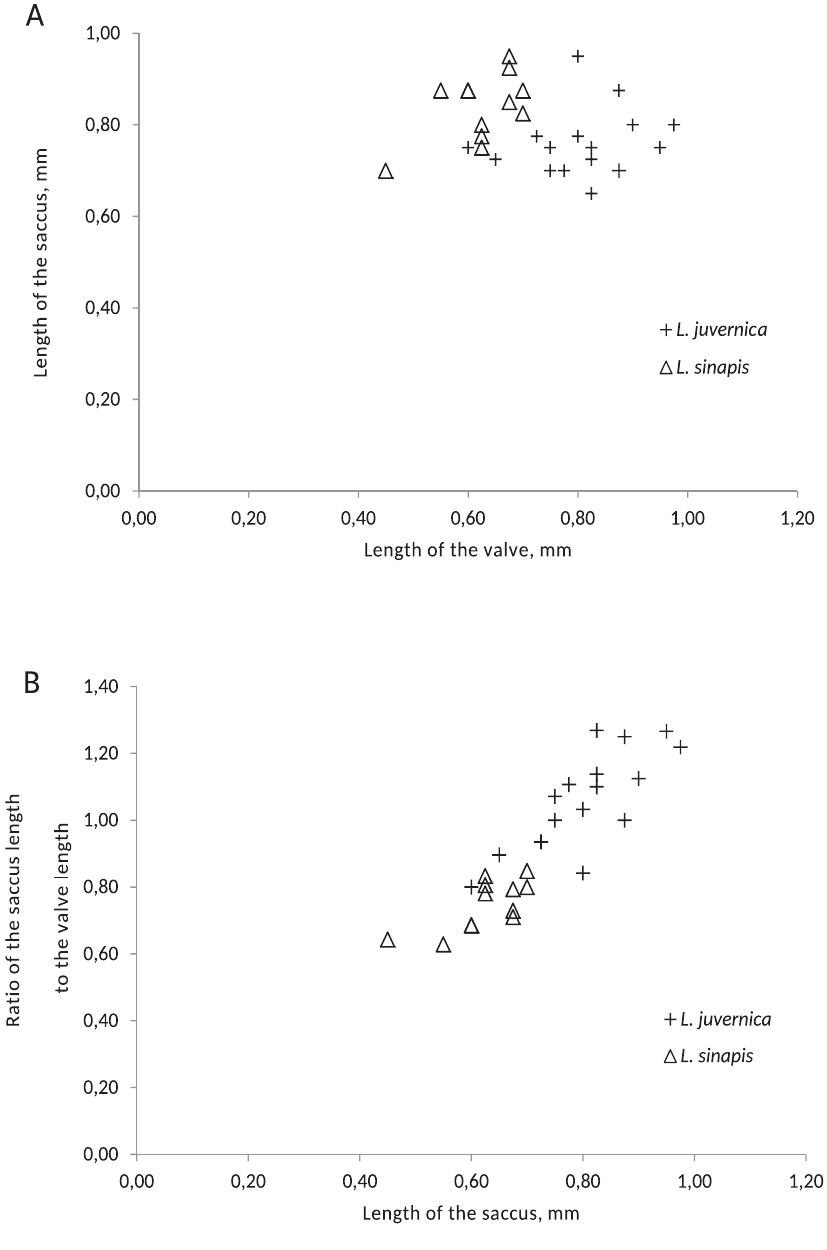
Figure 5. The saccus and valve lengths of the L. sinapis and L. juvernica . A Plot of the saccus length against the valve length of L. sinapis and L. juvernica , as identified by molecular markers B Plot of the ratio of the saccus length to the valve length against the saccus length for the same